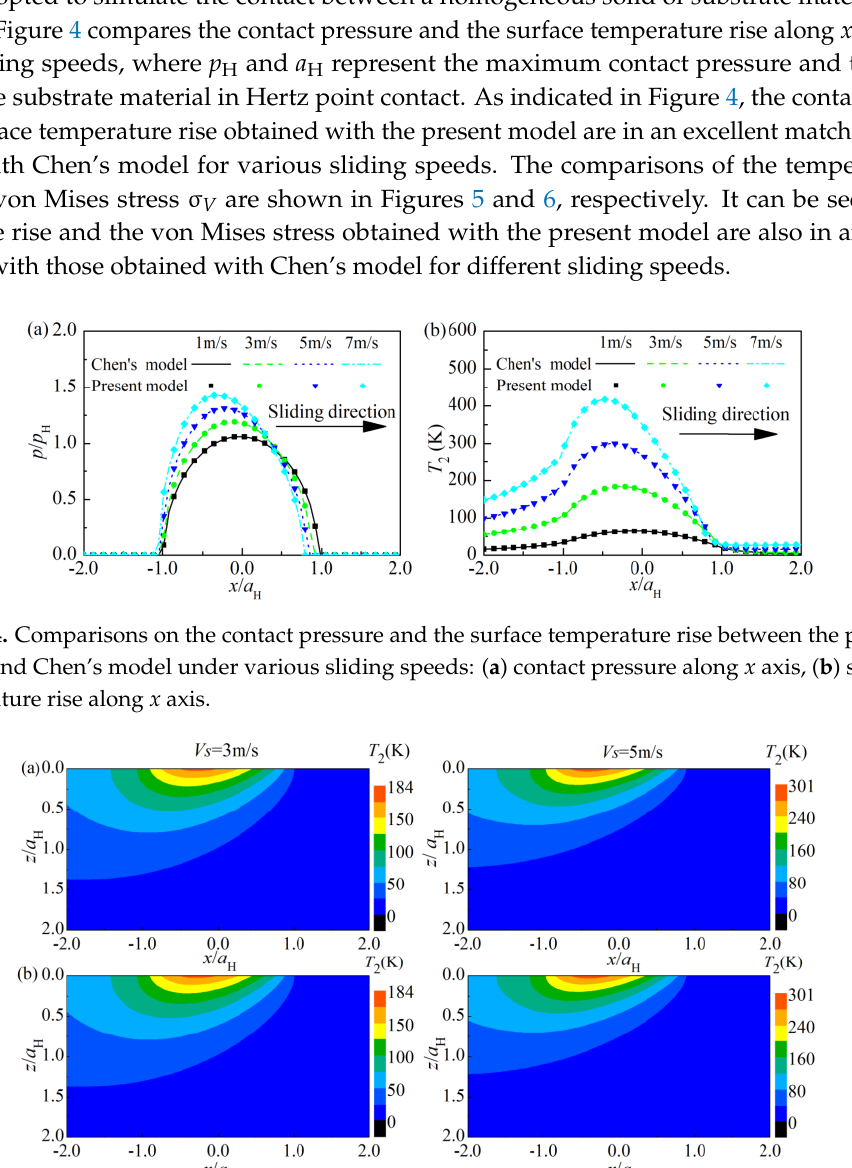
Figure 6. Comparison on the von Mises stress in xoz plane between the present model and Chen’s model under different sliding speeds: ( a ) solution of Chen’s model, ( b ) solution of the present model.